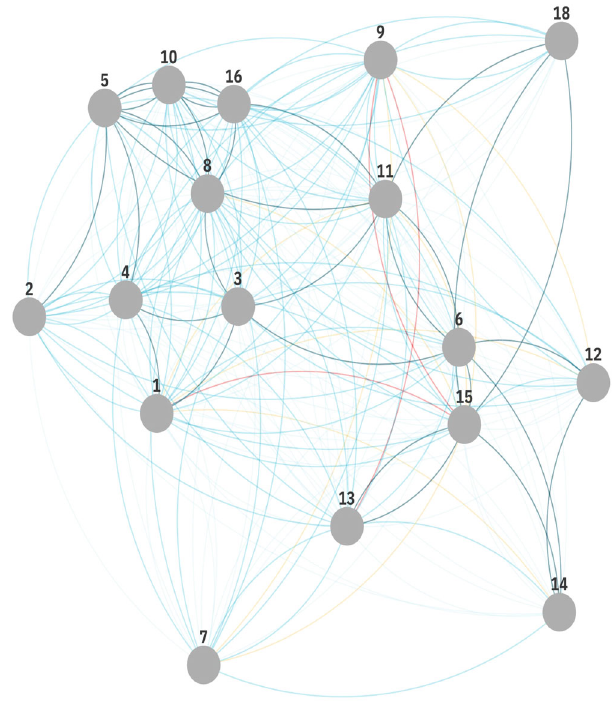
Fig. 2 Illustration of the full network of 17 goals and 272 linkages based on the cross-impact matrix. Cambodia Sustainable Development Goals 1 no poverty, 2 zero hunger, 3 child health, 4 quality education, 5 gender equality,